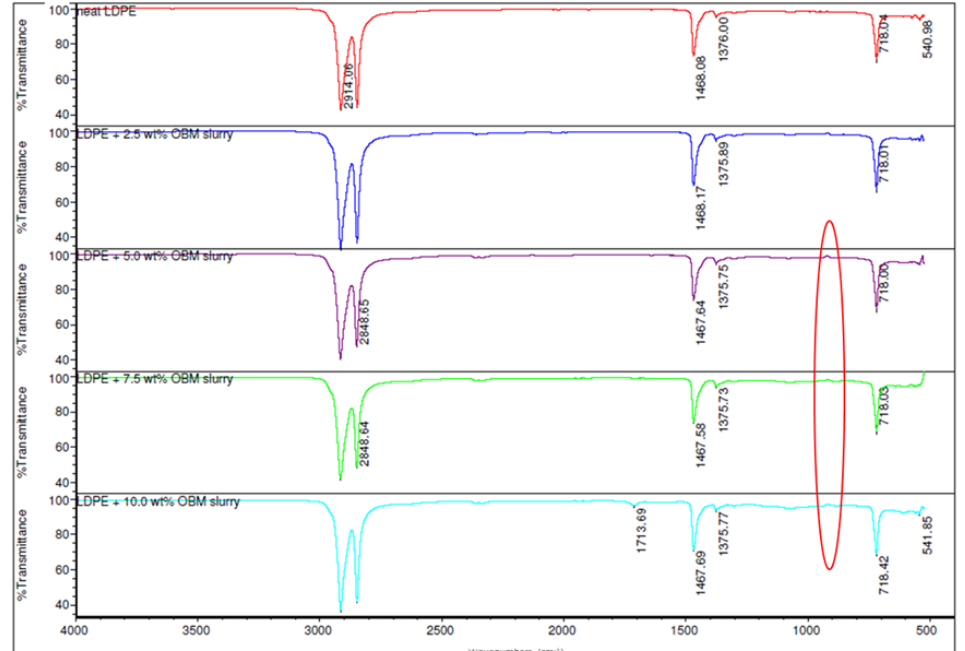
Figure 7. Comparison of ATR-FTIR spectra of LDPE and LDPE/OBM slurry nanocomposites.